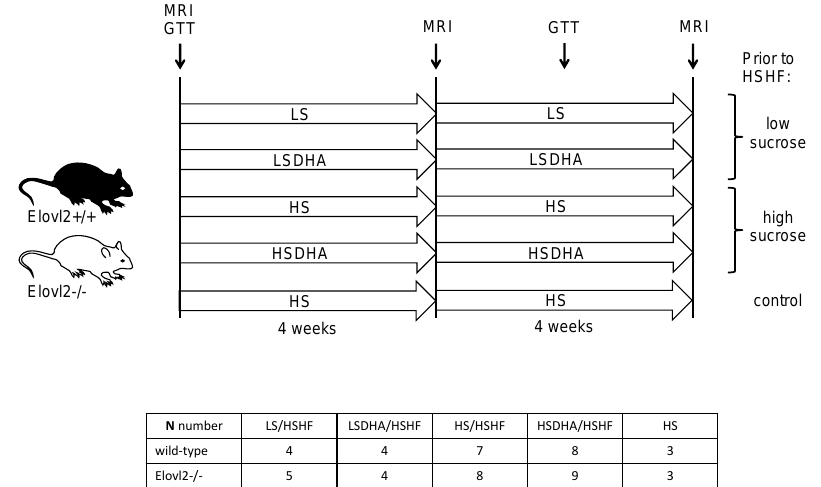
Figure 1. Experimental set-up. Wild-type and Elovl2 - / - mice were kept on low-sucrose (LS) or low-sucrose DHA-enriched diet (LSDHA) or on high-sucrose (HS) or high-sucrose DHA-enriched diet (HSDHA) for four weeks, followed by four weeks of high-sucrose, high-fat diet (HSHF) feeding. Control groups were kept on high-sucrose diet (HS) for eight weeks. Magnetic resonance imaging (MRI) was performed to measure fat and lean mass at the start point of the experiment, after four weeks pre-treatment and at the end of the experiment after four weeks of high-sucrose, high-fat diet. Glucose tolerance tests (GTT) were performed at the starting point and after six weeks of treatment (four weeks of pre-treatment and two weeks of high-sucrose, high-fat diet (HSHF).